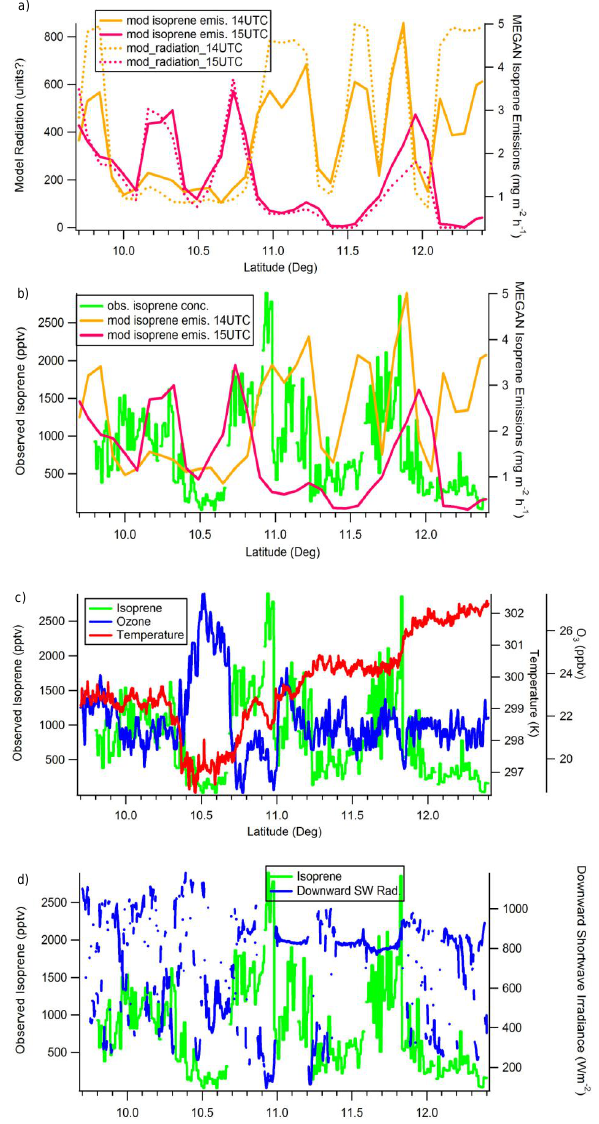
Fig. 10. The latitudinal variation of various parameters along the flight track of the low level run of flight B235 between 13:35 and 14:30UTC on 17 August 2006: modelled isoprene emissions rates and MM5 radiation for 14:00 and 15:00UTC (a) , observed and modeled isoprene (b) , observed isoprene, ozone mixing ratios and temperature (c) , observed isoprene and downward short wave radi- ation (d)